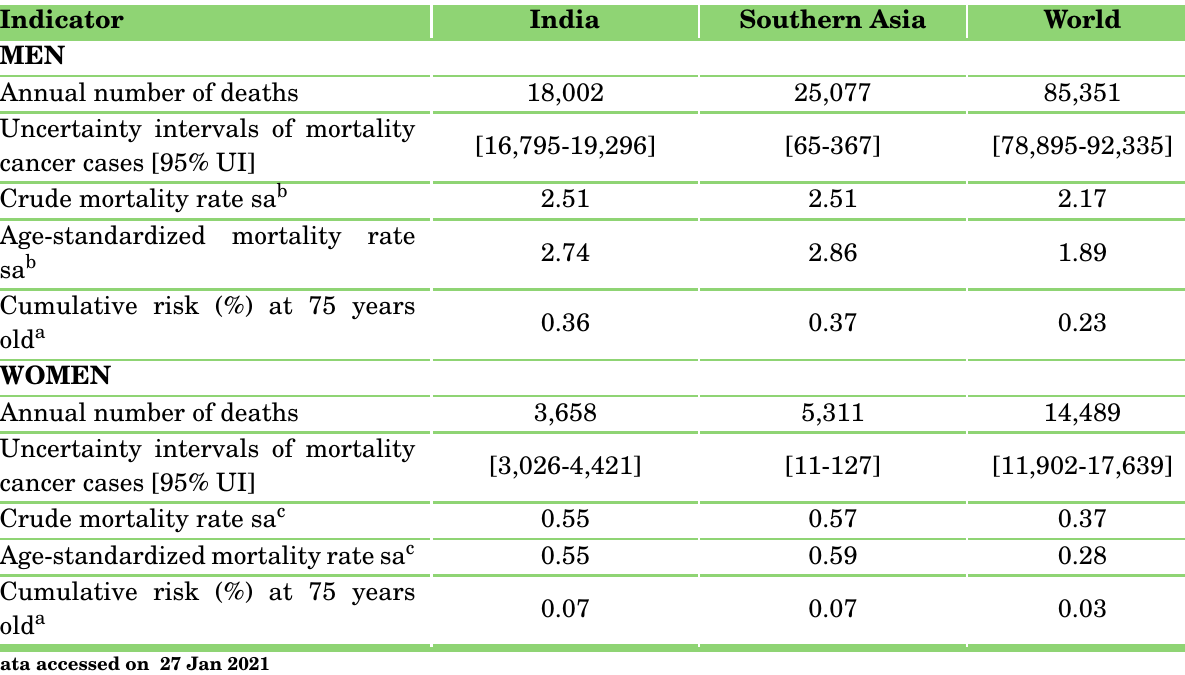
Table 20: Laryngeal cancer mortality in India (estimates for 2020) Indicator